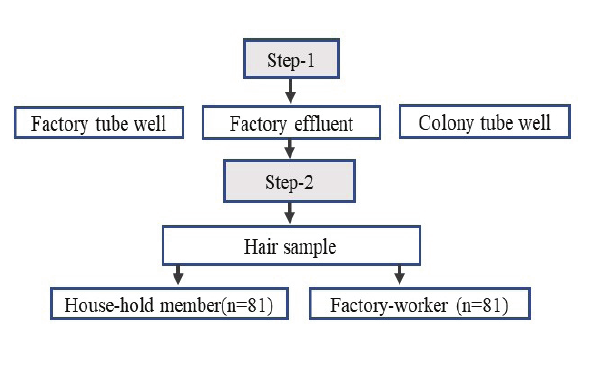
Figure-I: Study design and